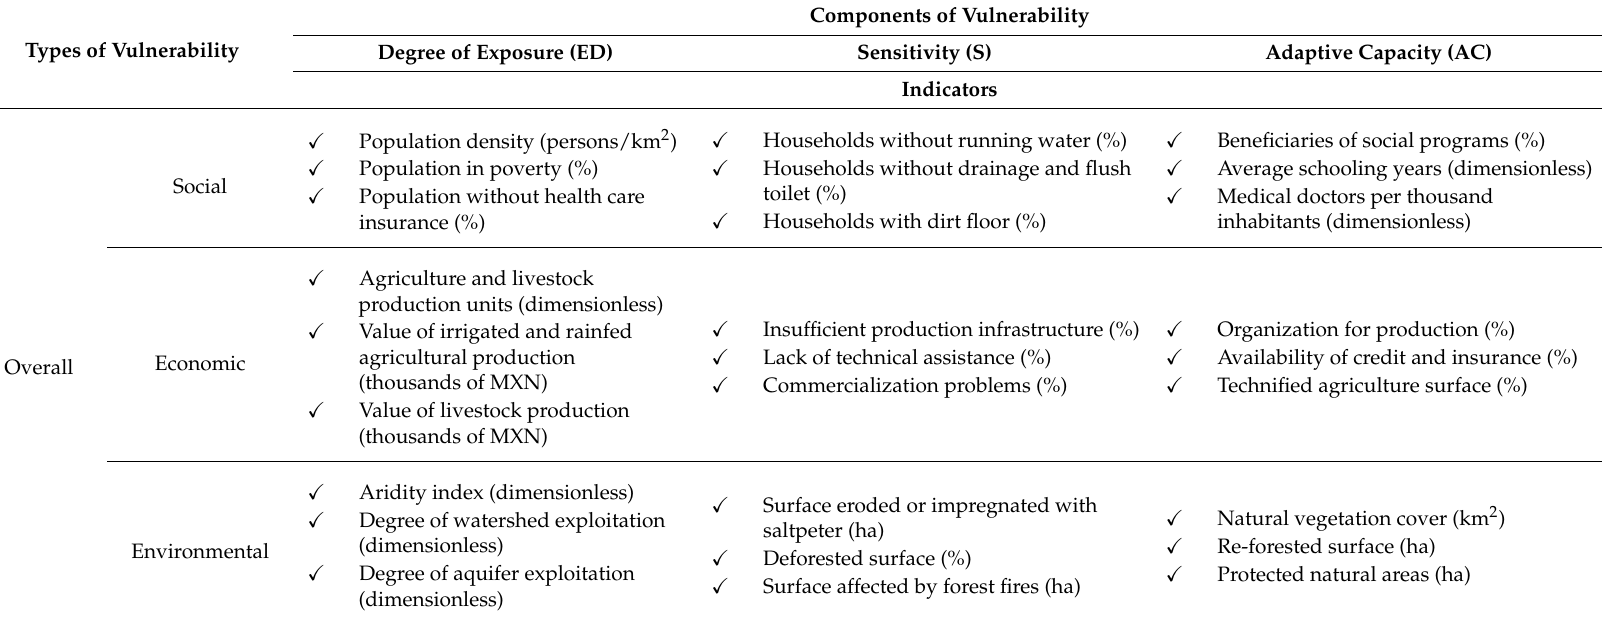
Table 1. Matrix showing the selected indicators, grouped by type and component of vulnerability to